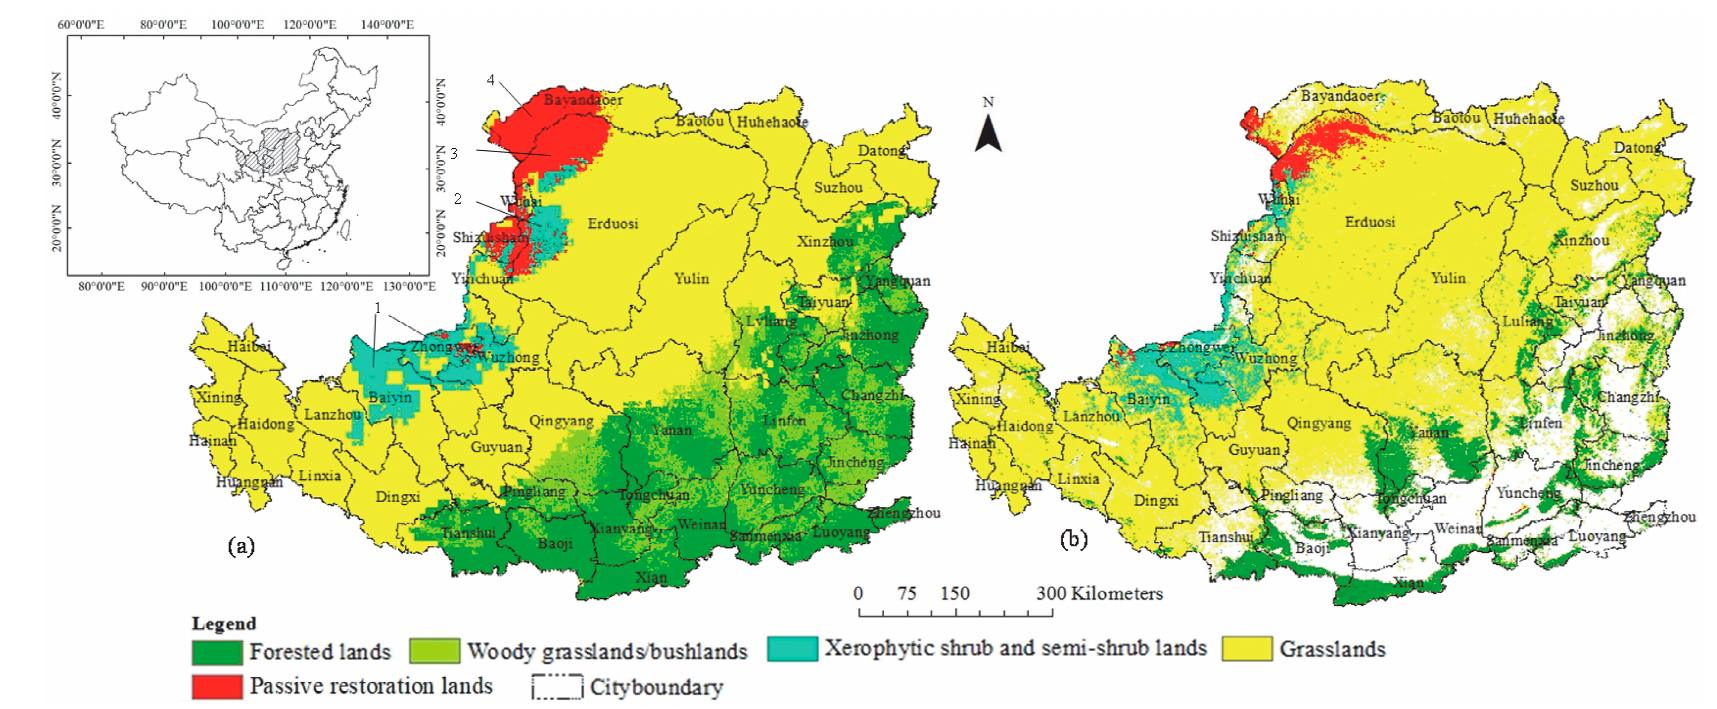
Figure 4. New regionalized vegetation restoration scheme ( a ) and land cover map (croplands, urban and built-up areas, and water bodies are not shown) for 2010 ( b ).